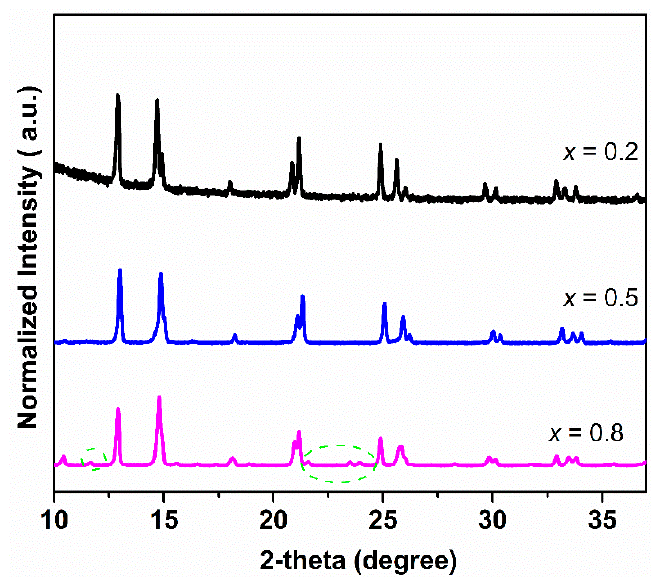
Figure 4. XRD patterns of Ce 0.9 Pr 0.1 O 2 − δ –Nd x Sr 1 − x Fe 0.9 Cu 0.1 O 3 − δ ( x = 0.2, 0.5, 0.8) samples after TGA measurements were made under a CO 2 atmosphere.